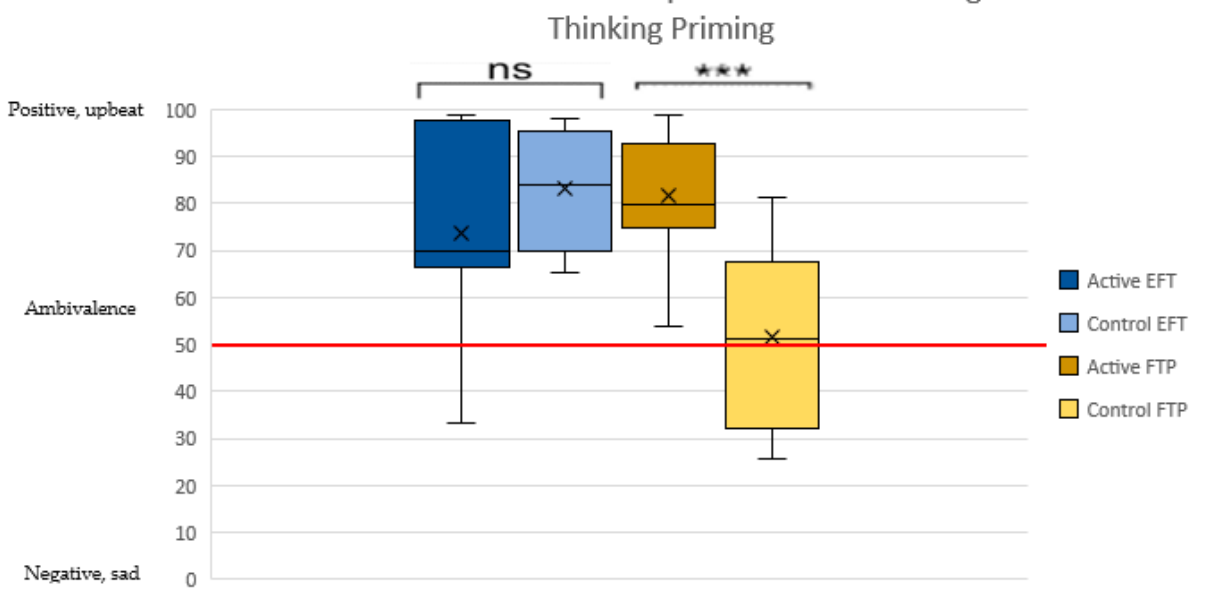
Figure 1. Emotional tone by Episodic Future Thinking and Future Thinking Priming active vs. control conditions. Emotional tone, a scale from 0–100, reflects a spectrum from negative, sad, anxious, or hostile (score of 0) to positive and upbeat (score of 100). Scores around 50, denoted by the red line, indicate ambivalence. Note: *** = p < 0.001, ns = not significant.